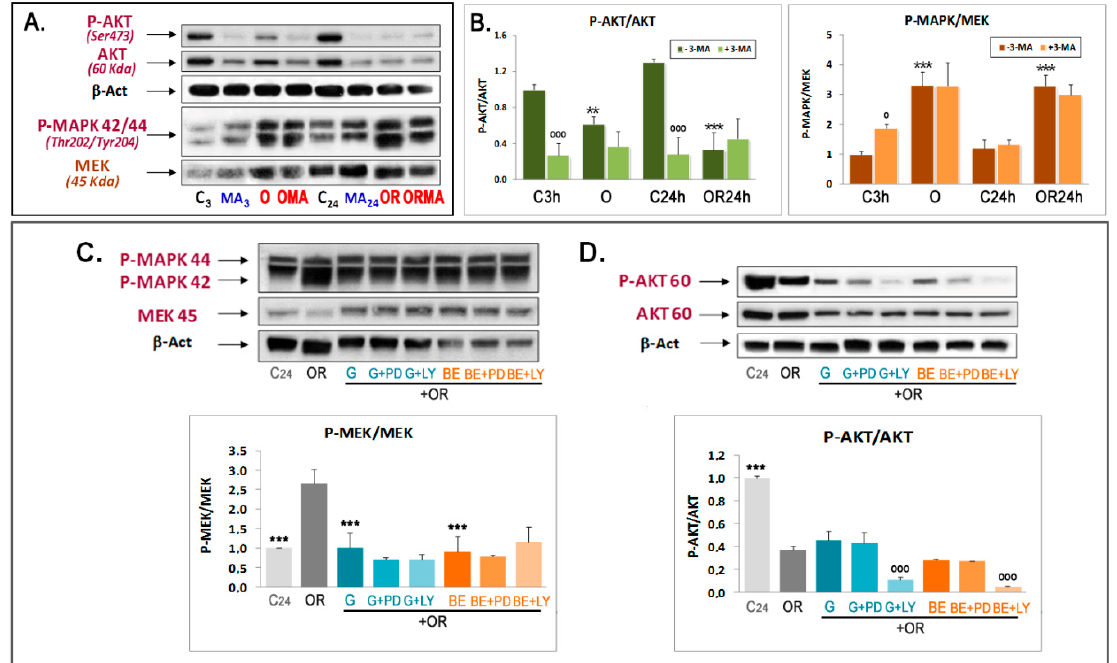
Figure 5. E ff ects of OGDR, phytoestrogens, and 3-MA treatment on AKT and MAPK phosphorylation. Figure 5. Effects of OGDR, phytoestrogens, and 3-MA treatment on AKT and MAPK Western blots of 473 SerP-AKT ( A , B , D ) and 202 P-Thr- and 204 P-Tyr-P-MAPK 42,44 ( A – C ) were performed phosphorylation. Western blots of 473 SerP-AKT (A , B , D) and 202 P-Thr- and 204 P-Tyr-P-MAPK 42,44 in extracts of cortical neurons subjected to 3 h OGD exposure (O) and 24 h OGDR (OR), in the absence (A – C) were performed in extracts of cortical neurons subjected to 3 h OGD exposure (O) and 24 h or presence of 5 mM 3-MA ( A , B ), or in the presence of 1 µ M Gen or BE with or without 5 µ M PD98059 OGDR (OR), in the absence or presence of 5 mM 3-MA (A , B), or in the presence of 1 μ M Gen or BE or 5 µ M LY294002 ( C , D ). Upper panels in ( C , D ) show representative Western blots. Lower panels with or without 5 μ M PD98059 or 5 μ M LY294002 (C , D). Upper panels in ( C , D ) show representative represent the quantitative analysis of indicated ratios and are mean ± SEM of three experiments, Western blots. Lower panels represent the quantitative analysis of indicated ratios and are mean ± each one performed in duplicate. Statistics in panel B compare the e ff ect of OR over their respective SEM of three experiments, each one performed in duplicate. Statistics in panel B compare the effect controls (***) or the e ff ect of 3-MA in each condition versus respective conditions in the absence of of OR over their respective controls (***) or the effect of 3-MA in each condition versus respective this compound (ooo). Statistics in panels ( C , D ) compare the e ff ect of OR alone versus C24h and after conditions in the absence of this compound ( ooo ). Statistics in panels ( C , D ) compare the effect of OR addition of phytoestrogens (***) or the e ff ect of PD or LY in each condition versus the same conditions alone versus C24h and after addition of phytoestrogens (***) or the effect of PD or LY in each in the absence of these compounds ( ooo ) at o p < 0.05, ** p < 0.01, *** p < 0.001 (one-way ANOVA condition versus the same conditions in the absence of these compounds ( ooo ) at * p < 0.05, ** p < 0.01, *** p < 0.001 (one-way ANOVA test).